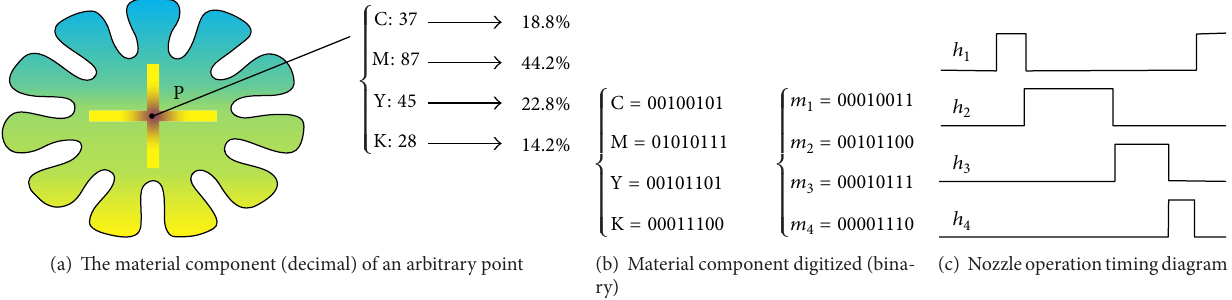
Figure 5: The material component of arbitrary point correspondence relationship with nozzle actions.